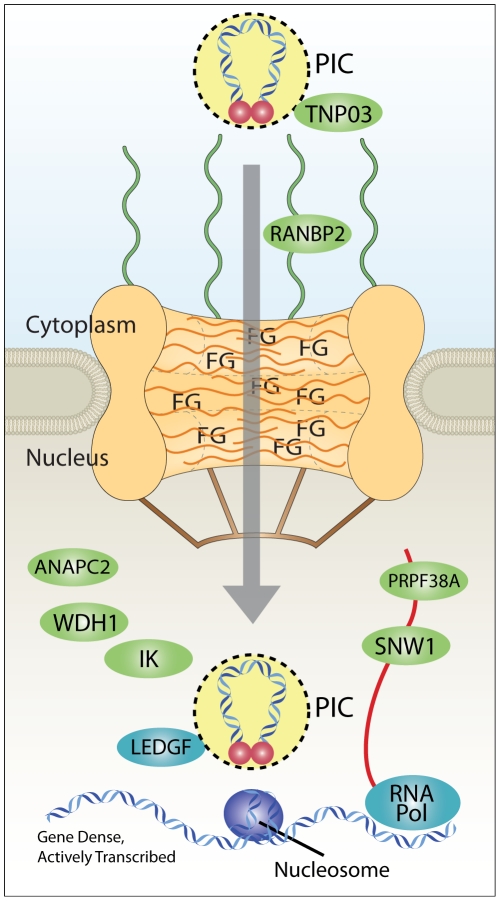
Model for coupling of nuclear import and integration targeting.Interaction with Transportin-3 and RanBP2 shuttles the PIC through the nuclear pore and toward gene dense regions favored for HIV integration. Interactions with additional factors in the nucleus (ANAPC2, WDH1, IK, PRPF38A, and SNW1) may also play a role in site selection upstream of the known integration cofactor Ledgf/p75, which targets integration to active transcription units. RNA Pol indicates RNA polymerase II, which is known to be required for transcriptional activity, and which promotes integration [13]–[15], [18]. Nucleosomes are shown because target DNA is known to be wrapped in nucleosomes during the integration step [36], [57]–[60]. PIC, preintegration complex; FG, phenylalanine-glycine repeat sequences of nuclear pore proteins.